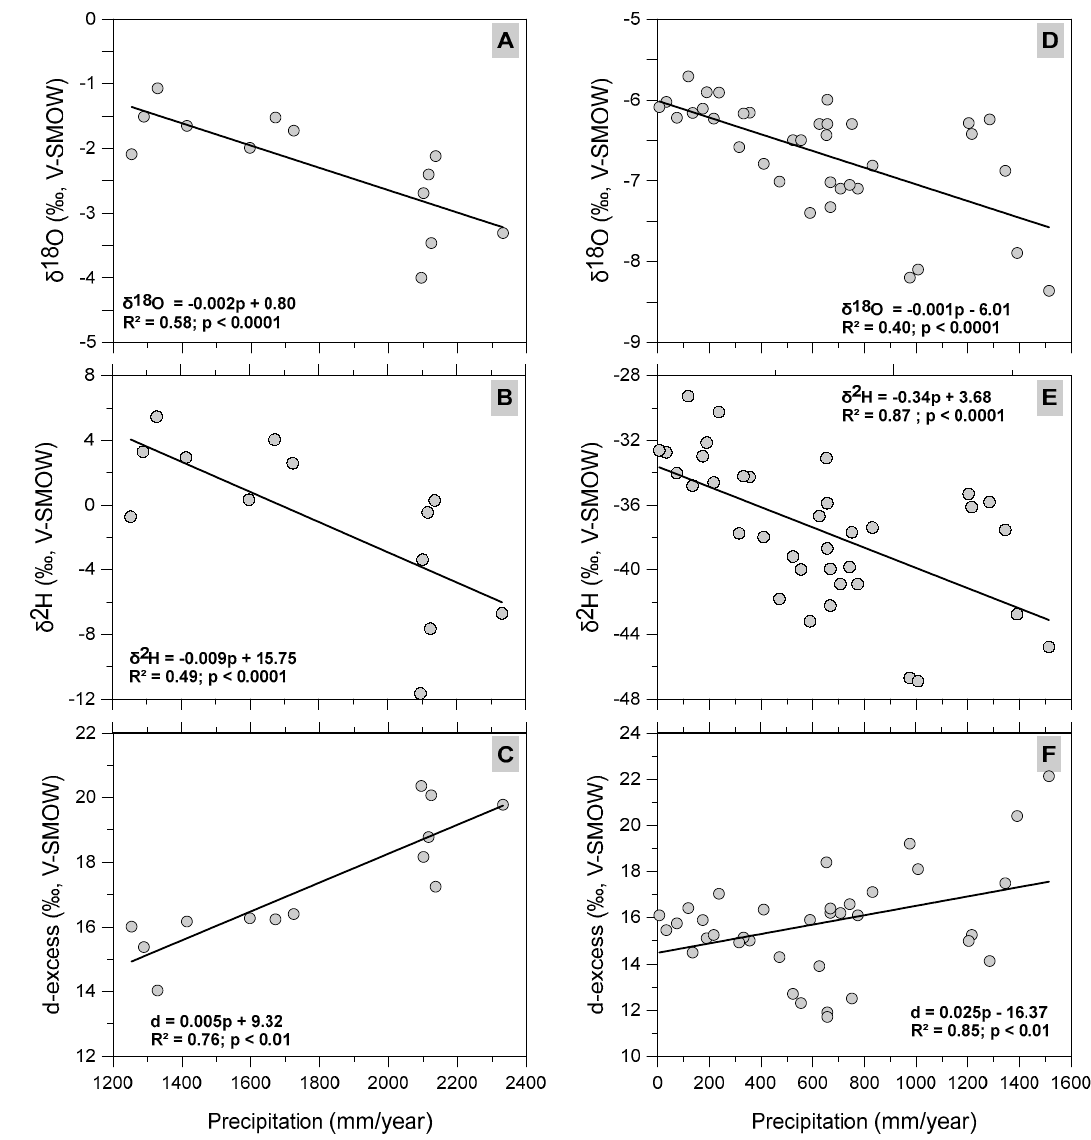
Figure 6. Mean precipitation-weighted δ 18 O, δ 2 H and d-excess values plotted against averaged annual precipitation in Virunga, located on the limit between Central and Eastern Africa, within the western branch of the East African Rift System ( A – C ), and southern Italy ( D – F ) in the Central Mediterranean (data are from Stromboli and Sicily). The two areas exhibit a different extent in the negative correlation between the isotope composition against the precipitation amount ( A , B , D , E ), and in the positive correlation between deuterium excess against the precipitation amount ( C , F ).